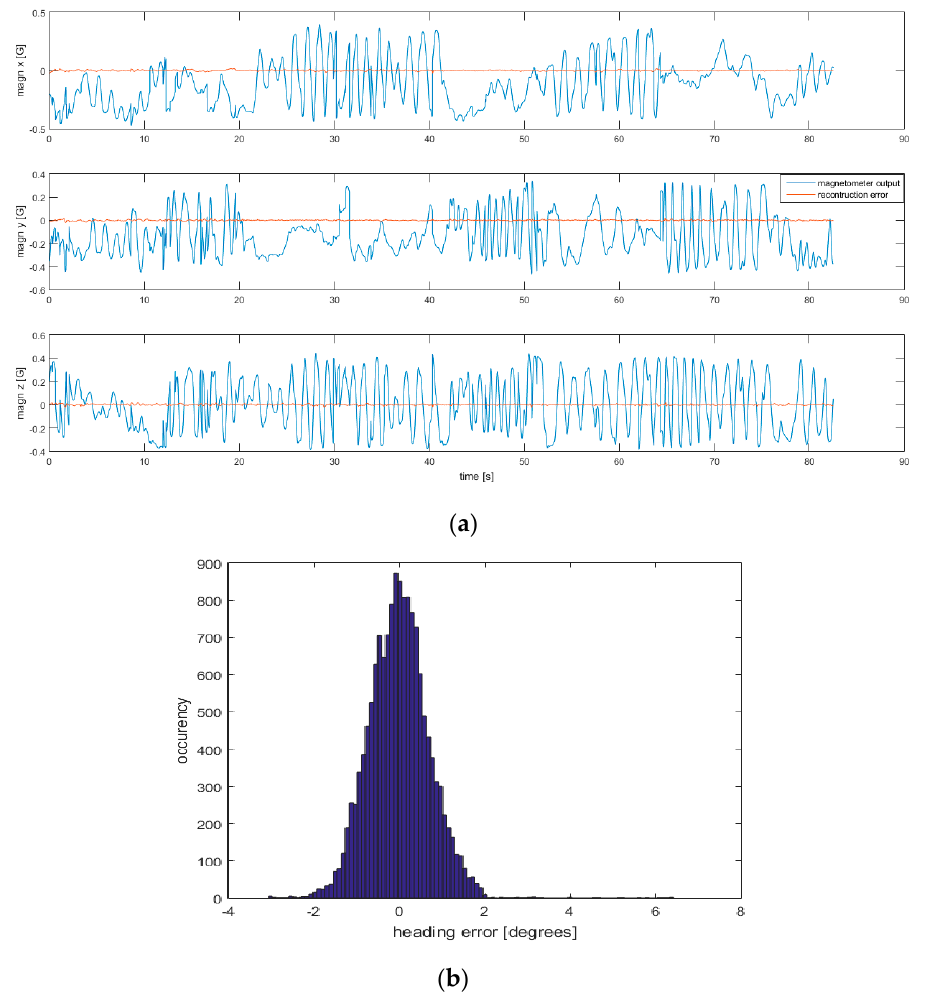
Figure 4. ( a ) example of magnetometer outputs (blue line) and reconstruction errors (red line) along the three local axes; ( b ) histogram of the heading error. The number of kernel points was fixed at 27.